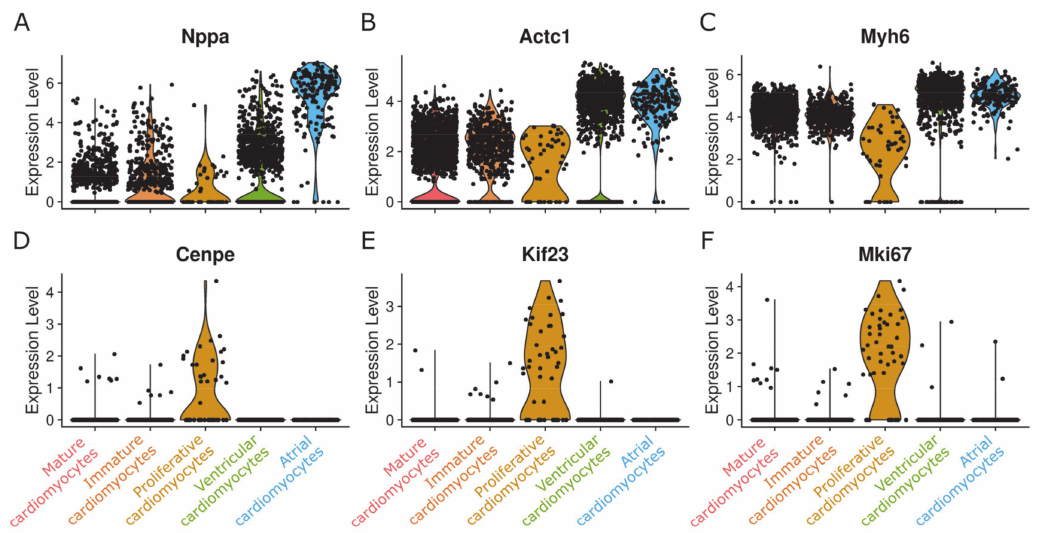
Figure 4. Violin plot of cardiomyocyte cell markers and markers for proliferation. ( A – C ) Three typical cardiomyocyte markers are expressed in comparable levels in all clusters considered as cardiomyocyte populations. ( D – F ) Markers for proliferation and cytokinesis are only expressed in one of the clusters, resulting in the annotation as “proliferative cardiomyocytes”.